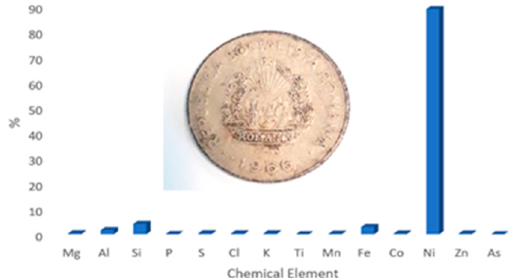
Figure 1. Elemental analysis of the